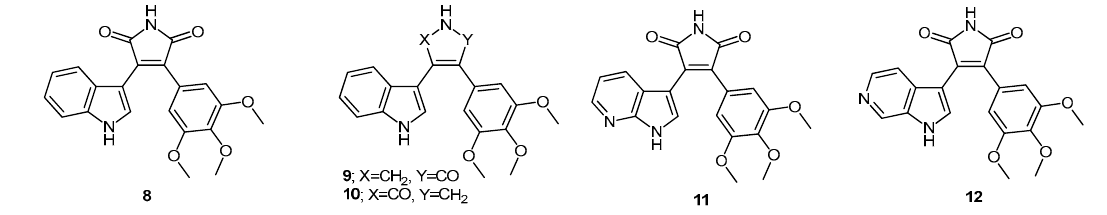
Figure 4. Maleimides 8 , 11 and 12 and pyrrolones 9 and 10 .